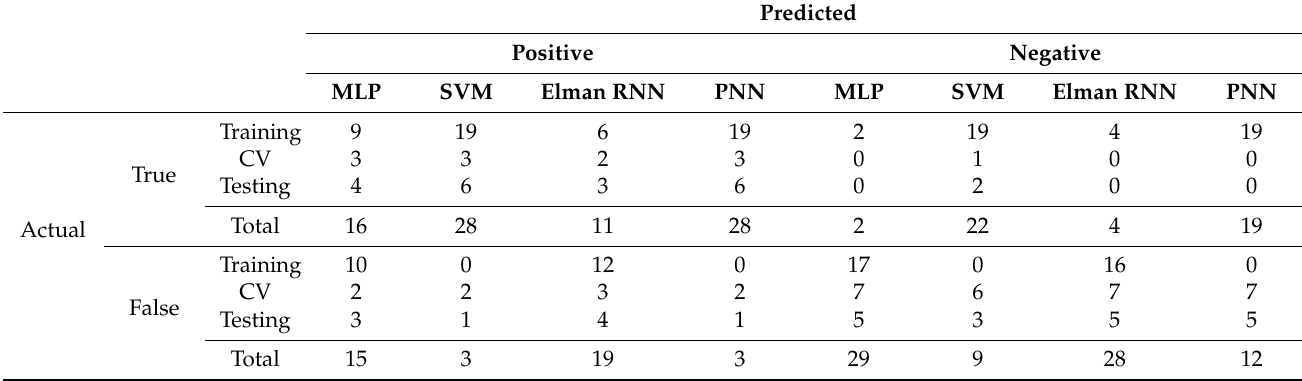
Table 5. Confusion matrix of MLP, SVM, Elman RNN and PNN model.